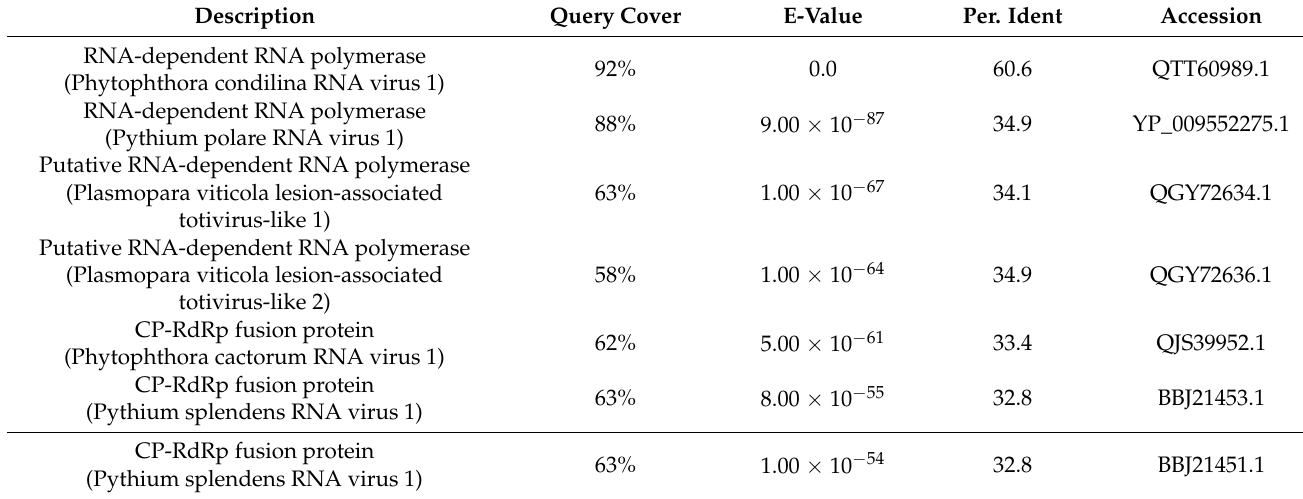
Table 1. List of oomycete viruses that were hit by the tBLASTx search of the PuRV2 ORF2. Description